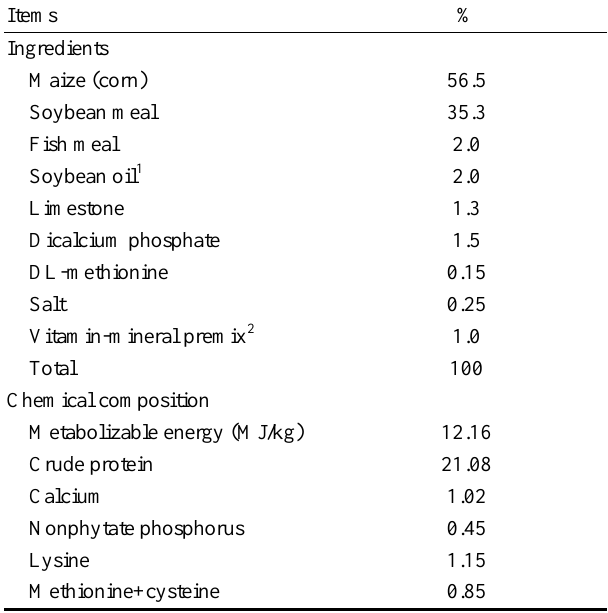
Table 1. Composition of the diets, as fed basis Items %